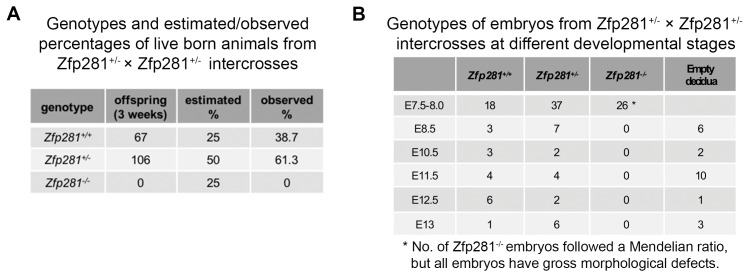
Summary of embryos recovered from intercrosses of heterozygous mice.(A) Genotypes and estimated (Mendelian)/observed percentages of live born pups from intercrosses of Zfp281+/- × Zfp281 ± mice. (B) Genotypes of embryos from intercrosses of Zfp281+/- × Zfp281 ± mice at different developmental stages.